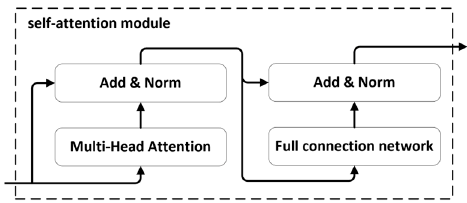
Figure 6. Self-attention module’s specific structure.